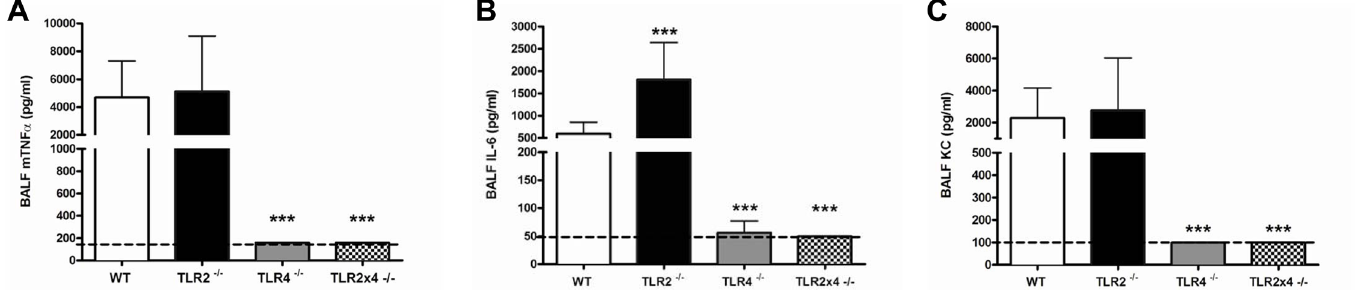
Fig 5. TLR4 -/- and TLR2x4 -/- , but not TLR2 -/- mice, display diminished cytokine responses to B . pseudomallei LPS-induced pulmonary inflammation in mice. mTNF- α (A), interleukin (IL)-6 (B) and KC (C) levels were determined in bronchoalveolair fluid (BALF) of wild-type (WT), TLR2 -/- , TLR4 -/- and TLR2x4 -/- mice 6h post-intranasal administration of 10 ug LPS of B . pseudomallei . Following a Kruskal-Wallis test, Mann-Whitney U-tests were performed. Data are presented as means ± SEM. N = 7 or 9 per group and experiments were performed in duplicate. *** P < 0.001 vs. WT.